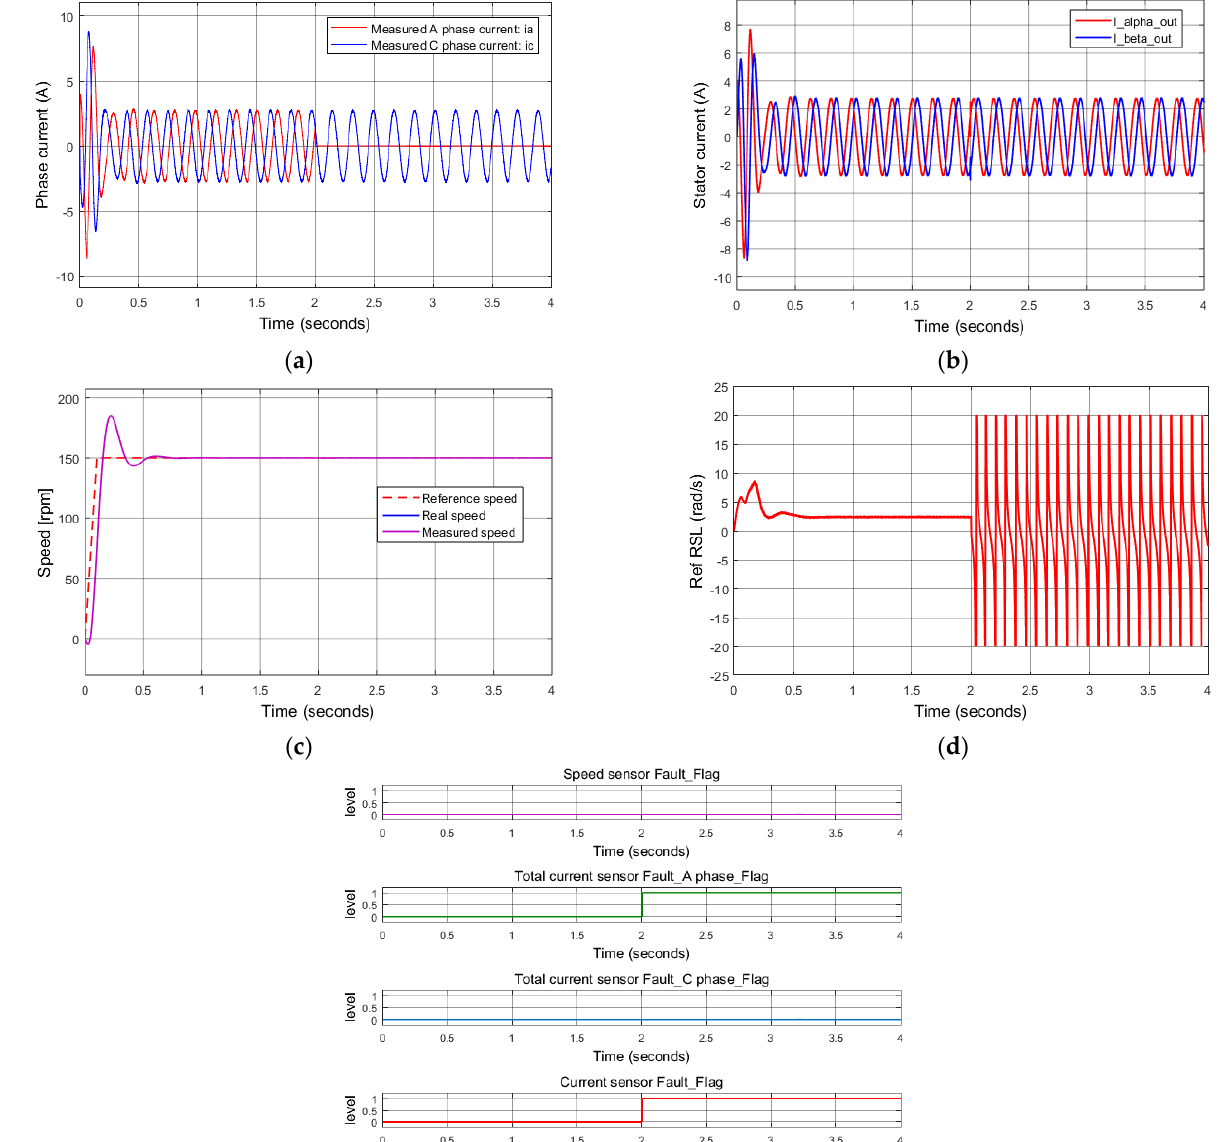
Figure 9. Simulation results: Total A phase current sensor failure at 2 s. ( a ) Measured currents; ( b ) stator current vector components for FOC controllers (FTC outputs); ( c ) reference, real, measured speeds; ( d ) reference rotor slip; ( e ) sensor fault indications.